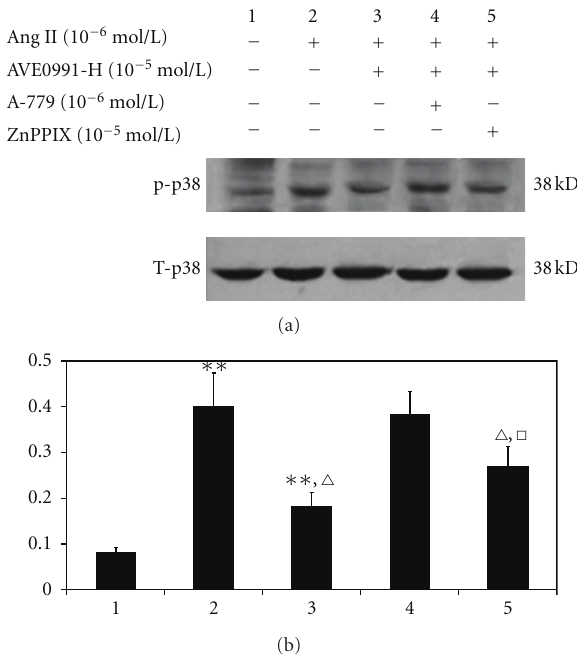
Figure 9: The e ff ect of AVE0991 on the p38 phosphorylation level in VSMCs when combined with the HO-1 inhibitor ZnPPIX. ∗∗ P < 0 . 01 versus control group; (cid:5) P < 0 . 01 versus Ang II group; (cid:2) P < 0 . 01 versus Ang II + AVE0991 group; n =